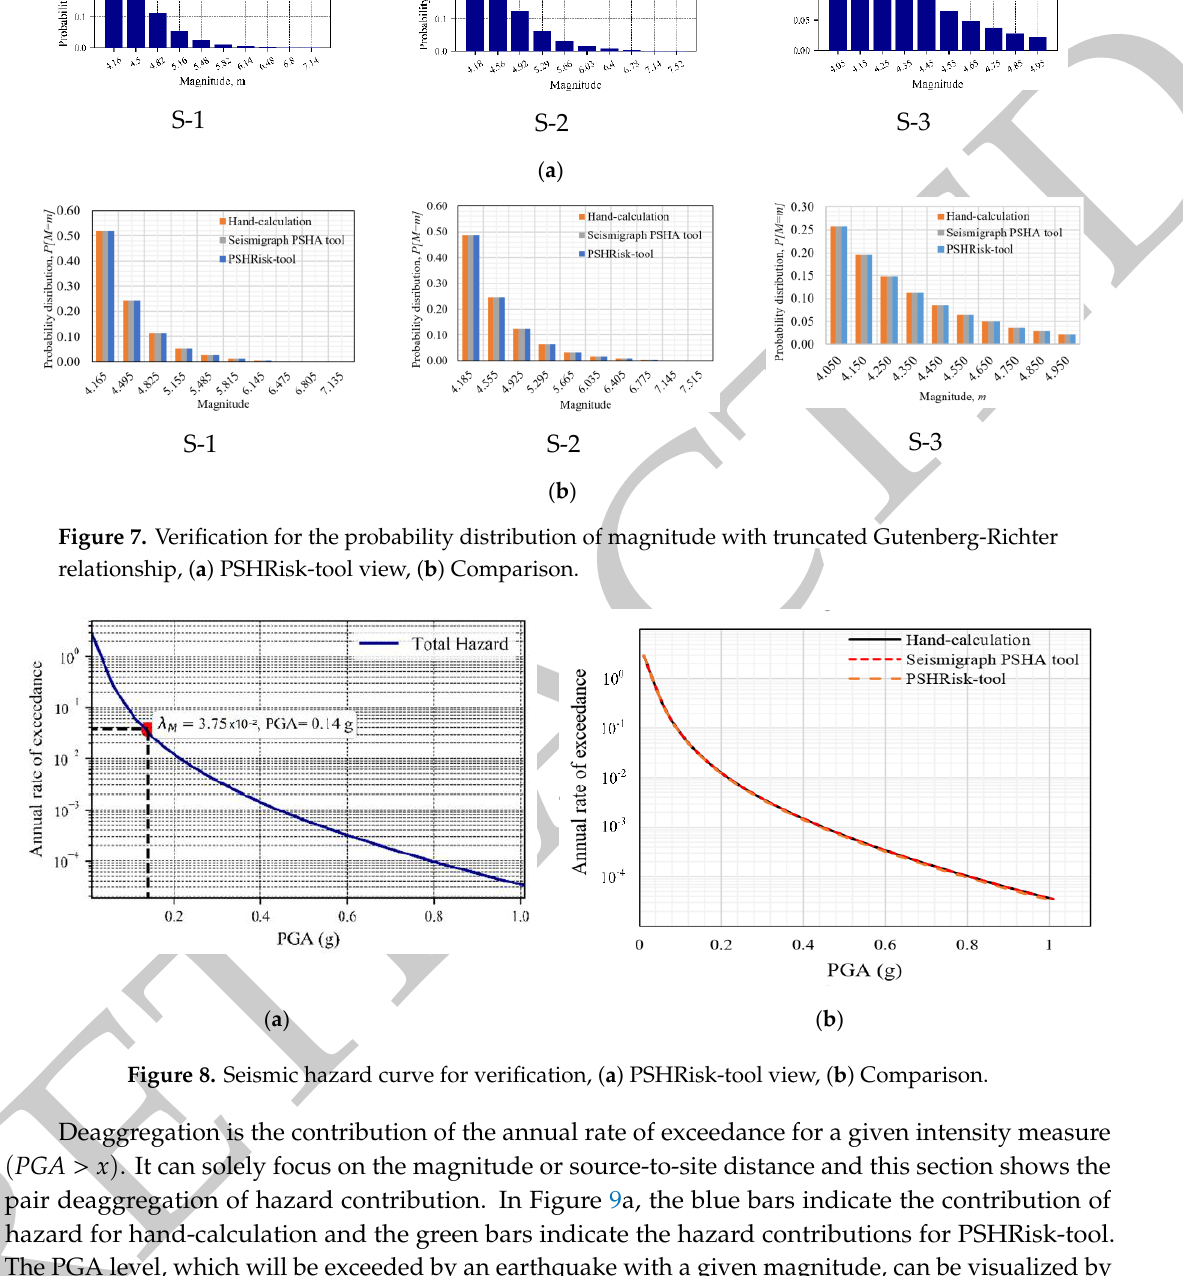
Figure 8. Seismic hazard curve for verification, ( a ) PSHRisk-tool view, ( b ) Comparison.